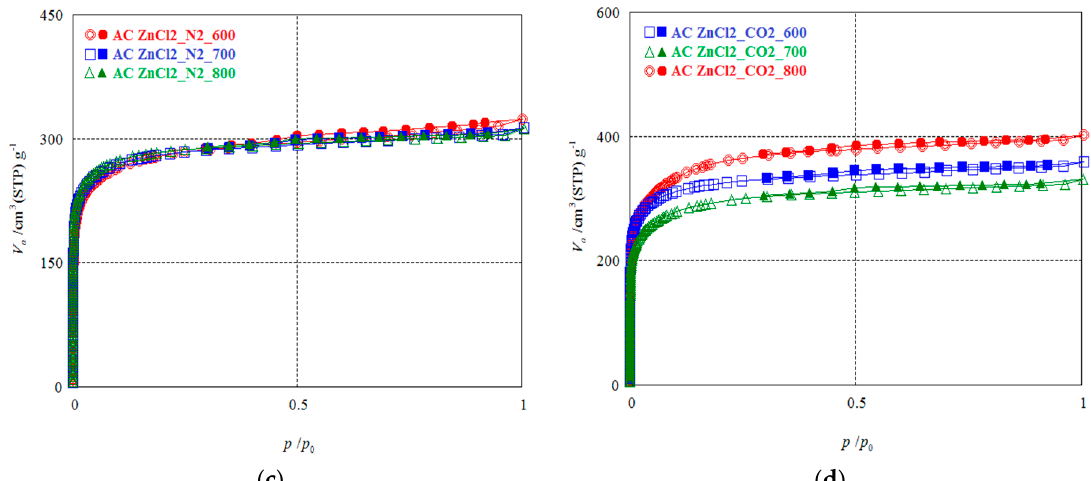
Figure 6. ( a ) Adsorption/desorption of AC prepared from pea pods impregnated using ( a ) KOH and carbonized under N 2 gas flow, ( b ) KOH and carbonized under CO 2 gas flow, ( c ) ZnCl 2 and carbonized under N 2 gas flow, and ( d ) ZnCl 2 and carbonized under CO 2 gas flow.